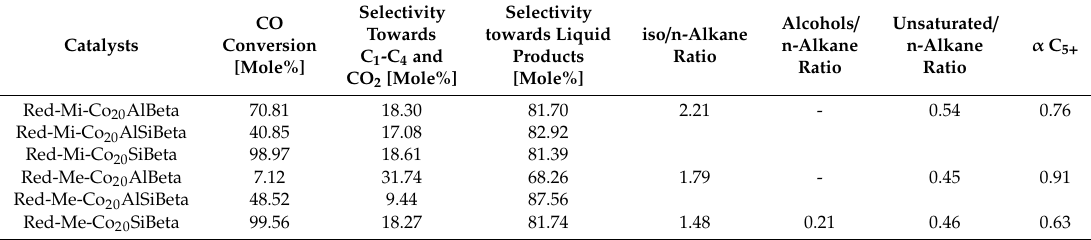
Table 3. The catalytic performance of tested samples after 20 h of